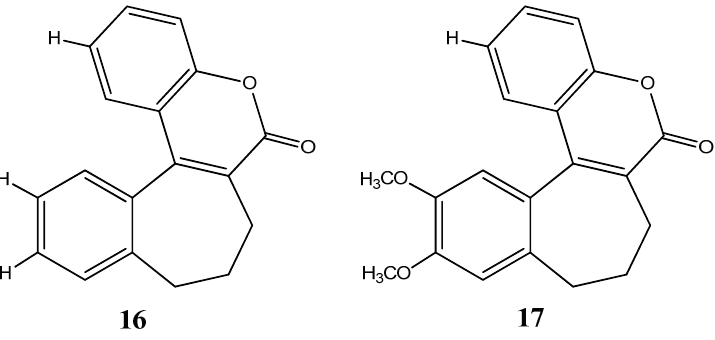
Figure 10. Chemical structure representation of synthetized benzosuberone derivatives bearing coumarin moieties with promising antiproliferative activity against A549, HeLa, MCF7 and MDA-MB-231 cell lines [41].